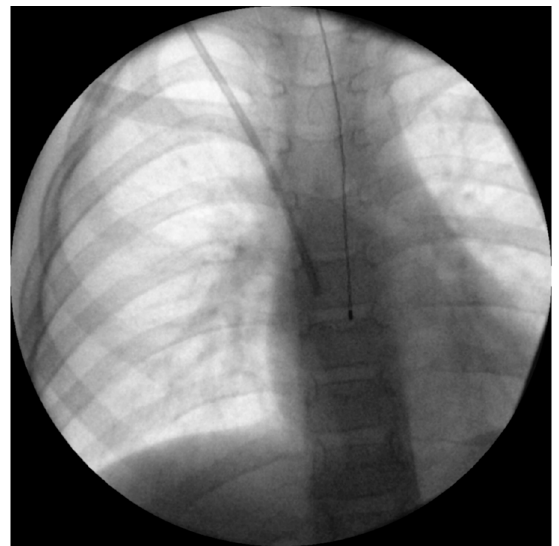
Figure 2. Intraoperative X-ray of a 6-year-old boy undergoing Broviac catheter implantation with appropriate depth of oesophageal temperature probe inserted, according to the estimation method by Whitby et al. [64].